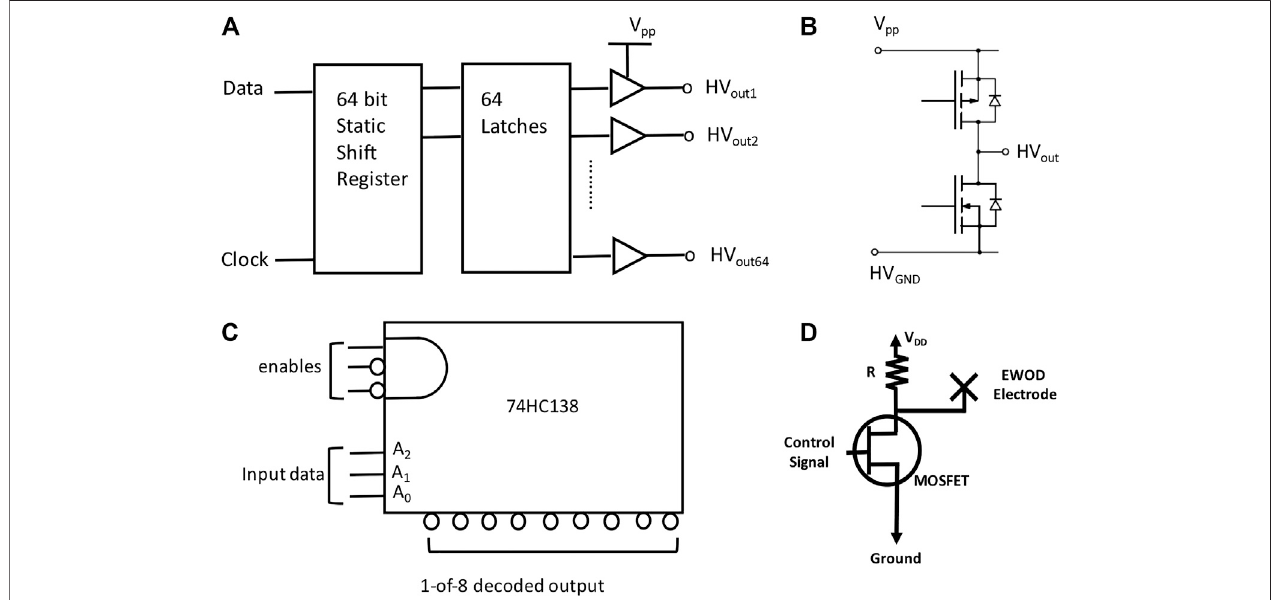
FIGURE 2 | Serial converter and multiplexor. (A) Functional diagram of HV507. The HV507 used in one version of OpenDrop (Alistar and Gaudenz, 2017) is a low- voltage serial-to-high-voltage parallel converter with 64 push – pull outputs. The device consists of a 64-bit shift register and 64 latches (Adapted from datasheet of Supertex Inc.). (B) Output equivalent ofHV507. (C) Functional diagram of74HC138. The74HC138 accepts athree-bit binaryaddressoninputpins A0,A1, andA2and produces a 1-of-8 decoded output (Horowitz and Hill, 1980). The multiple enable lines allow for the parallel expansion of decoders. (D) Switching circuit based on an FET and a resistor load. A control signal is applied to the gate of the metal-oxide FET (MOSFET) for the switching operation (Guo et al.,